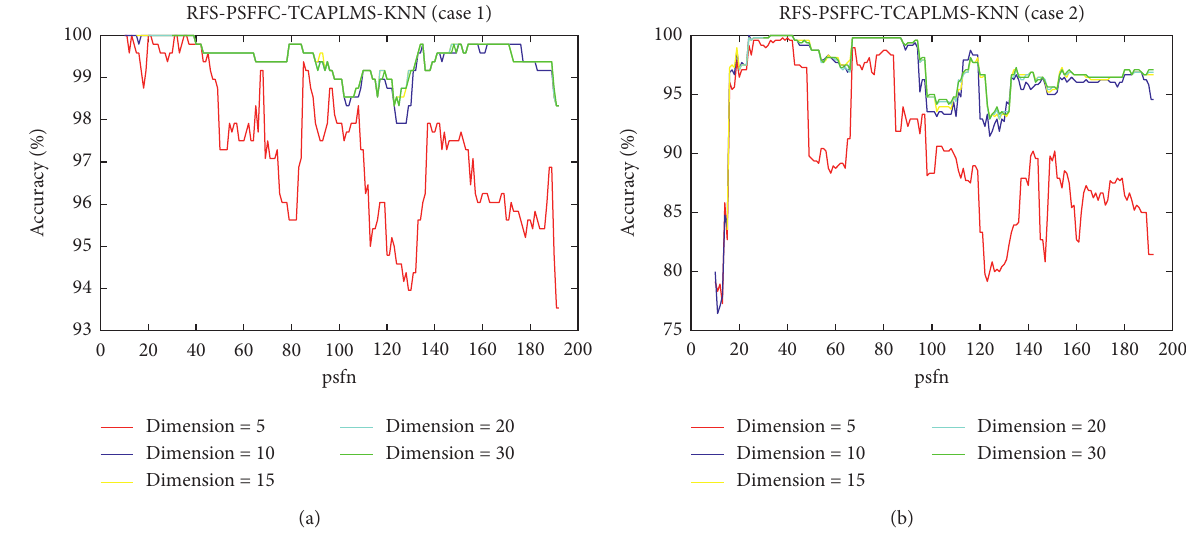
Figure 21: The testing accuracies of RFS-PSFFC-TCAPLMS-KNN with different dimension sizes for